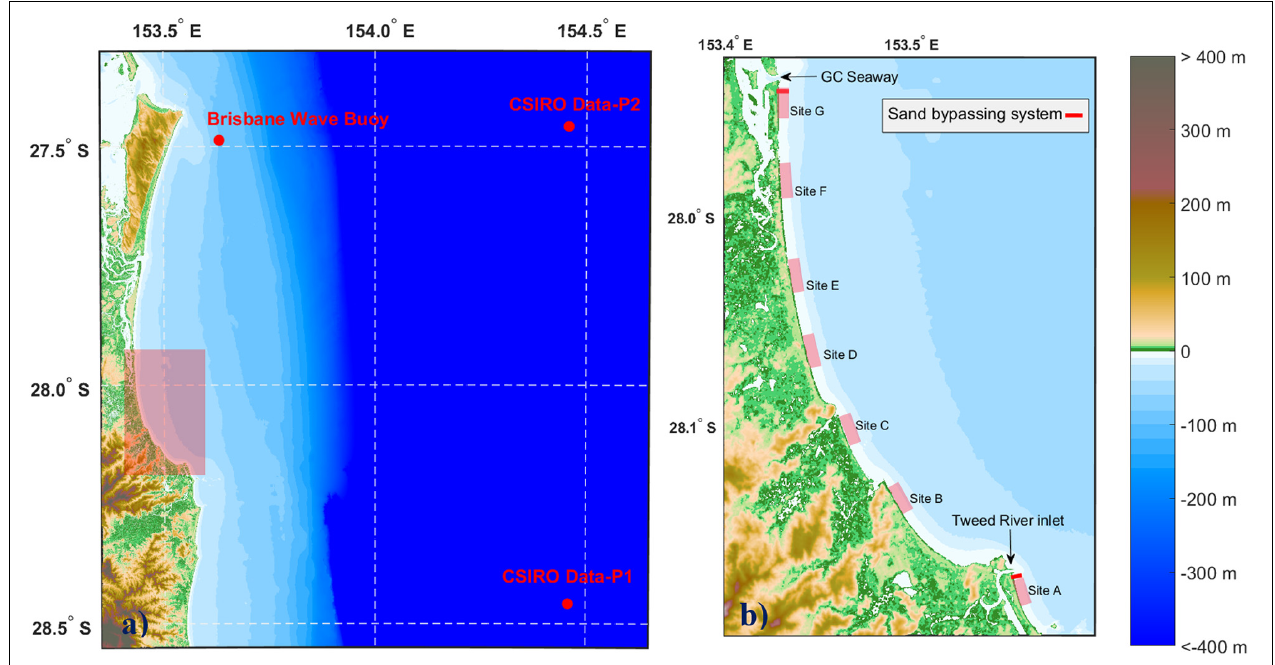
FIGURE 1 | (a) Study area (highlighted); (b) Location of sites selected for LST projections (adopted from Zarifsanayei et al., 2022).